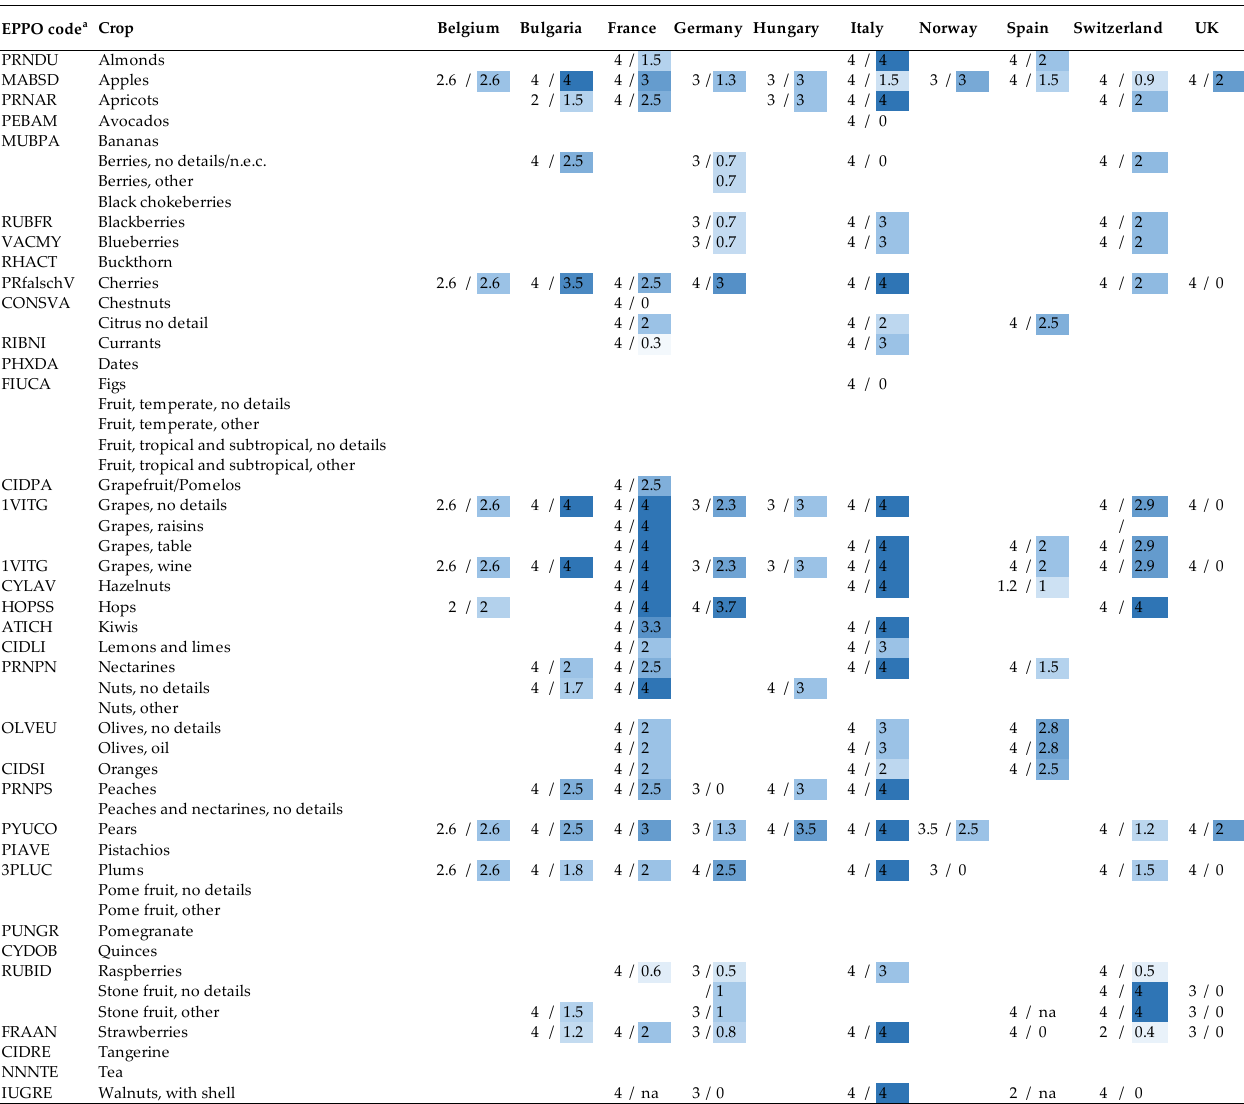
Figure 1. Copper-use authorizations and estimated real use in perennial crops in organic farming (authorized use/real use) in kg per ha and year in organic farming in the 12 surveyed European countries. Colors visualize intensity of use (from no use (white) to a maximum of 4 kg (dark blue)). a EPPO codes according EPPO Global Database. https://gd.eppo.int (accessed on 7 March